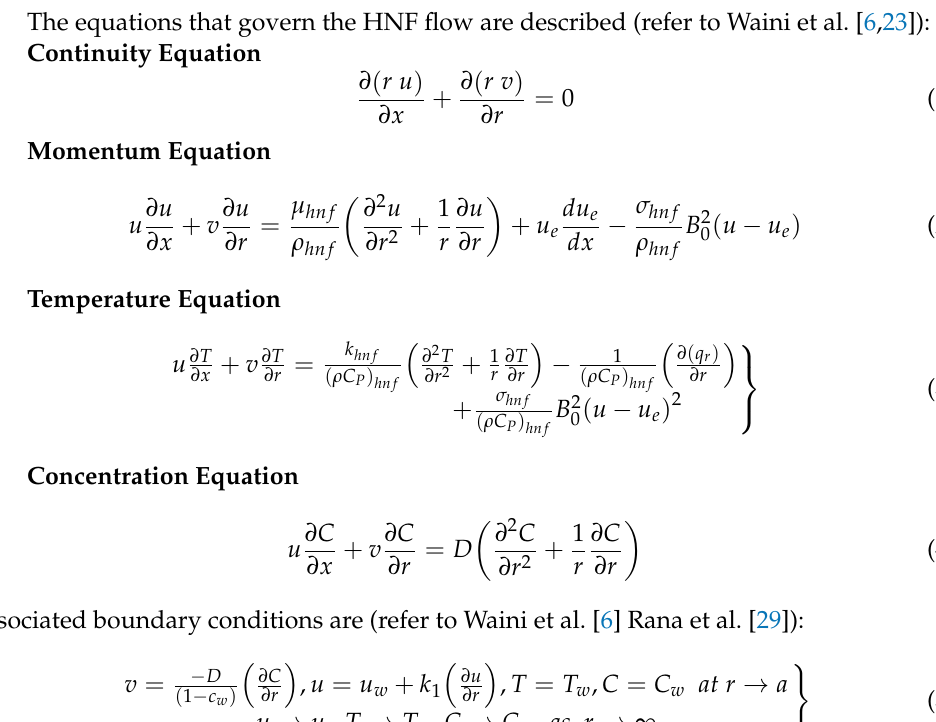
Figure 1. Physical Figure 1. Physical model.